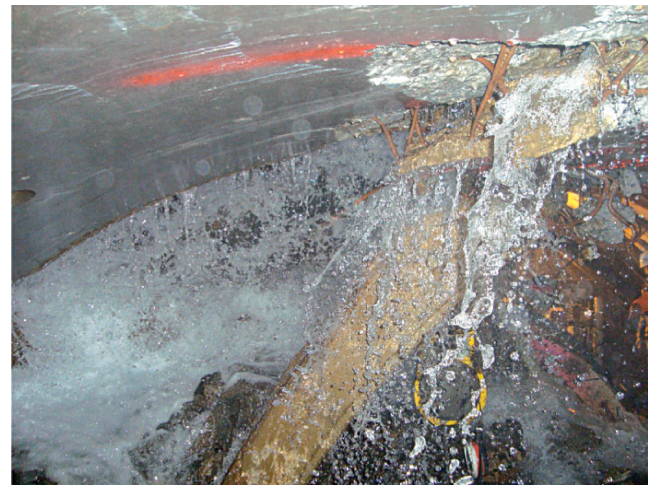
Figure 13. Water inrush and broken crown segments in TVHP (Source: Brandl et al. [49]). Several remedial measures were taken to overcome the collapse and water